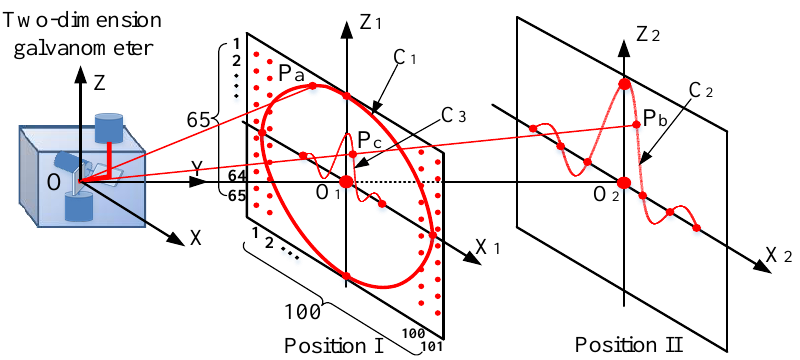
Figure 5. Calibration data generation.